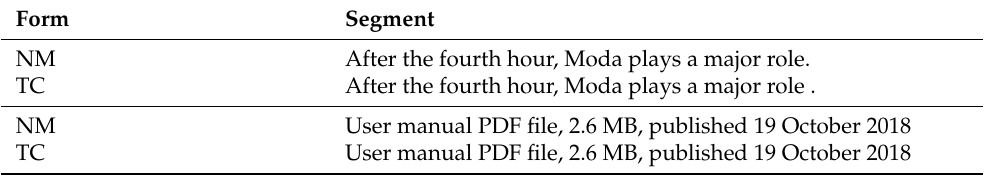
Table 2. Comparison between normalized segments (NM), and tokenized and truecased segments (TC). Form Segment NM After the fourth hour, Moda plays a major role.